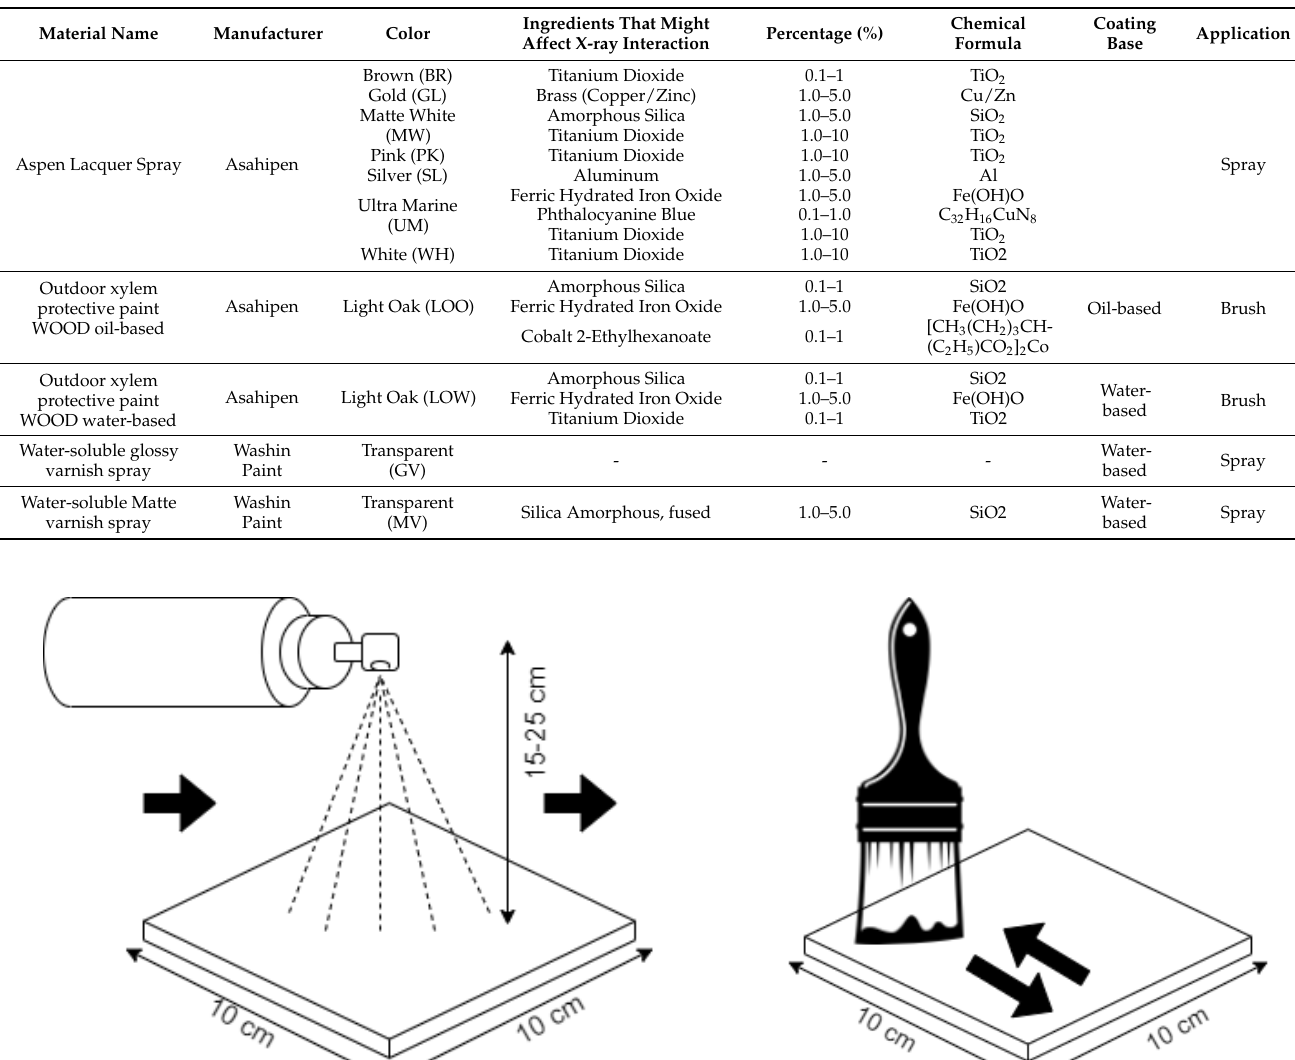
Table 1. Specifications of coatings.